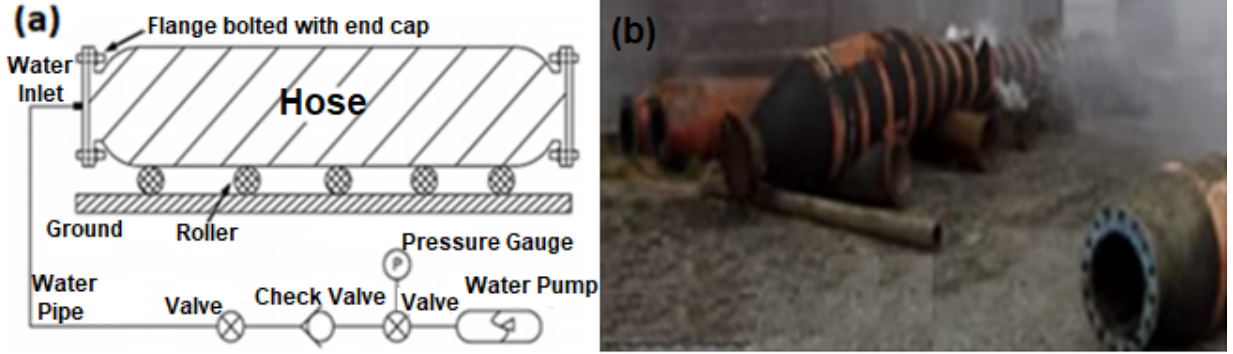
Figure 28. Two setup diagrams for Burst Test on OCIMF offshore hose, showing (a) the circuit diagram for burst test, and (b) the typical burst test on a marine hose.